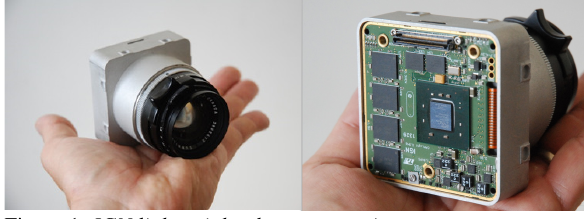
Figure 1. IGN lightweight photgrammetric camera CMV20000-CMOS Sensor (20 MP)